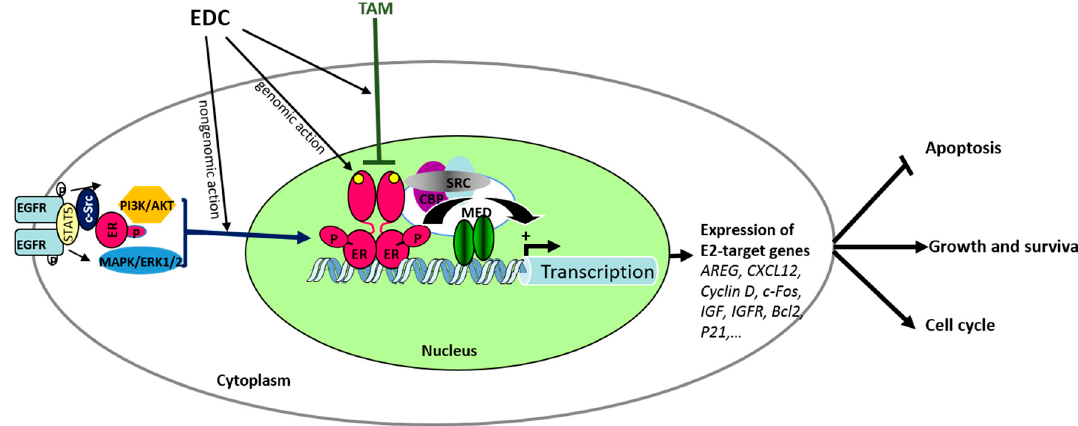
Figure 2. Ability of endocrine disrupter chemicals (EDCs) to alter estrogen signaling. At the cellular level, many EDCs can mimic the effects of estrogens through estrogen receptors (ERs). In the nucleus, EDCs are able to modulate transcription of E2-target genes (genomic action) by activating ER and the recruitment of cofactors such as CBP and SRC1, possessing intrinsic histone acetyltransferase activity, and the multiprotein mediators (MED) capable of modifying the chromatin organization of the specific gene promoter. In the cytoplasm, EDCs are able to interfere with pre-existing pathways (non-genomic action) altering interactions between ER and intracellular kinases (c-Src, MAPK, PI3K). EDCs like bisphenol A and diethylstilbestrol may induce rapid activation of MAPK or PI3 kinase signaling cascades, leading to ERK (extracellular-signal-regulated kinase) and AKT (Protein Kinase B) phosphorylations, intracellular calcium variations, or stimulation of cAMP production. Consequently, EDCs may influence cellular phenotypes, by genomic and non-genomic actions and responsiveness to antiestrogen tamoxifen (TAM) by changing the nuclear/cytoplasmic ER activity and expression, as well as the epigenetic and transcriptional regulations of various E2-target genes. EGFR: epidermal growth factor receptor.